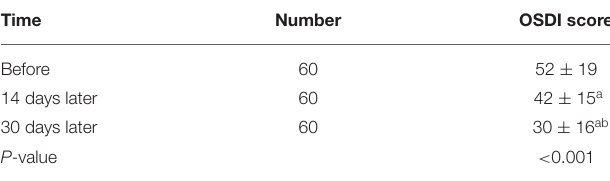
TABLE 1 | Changes in OSDI score before and after